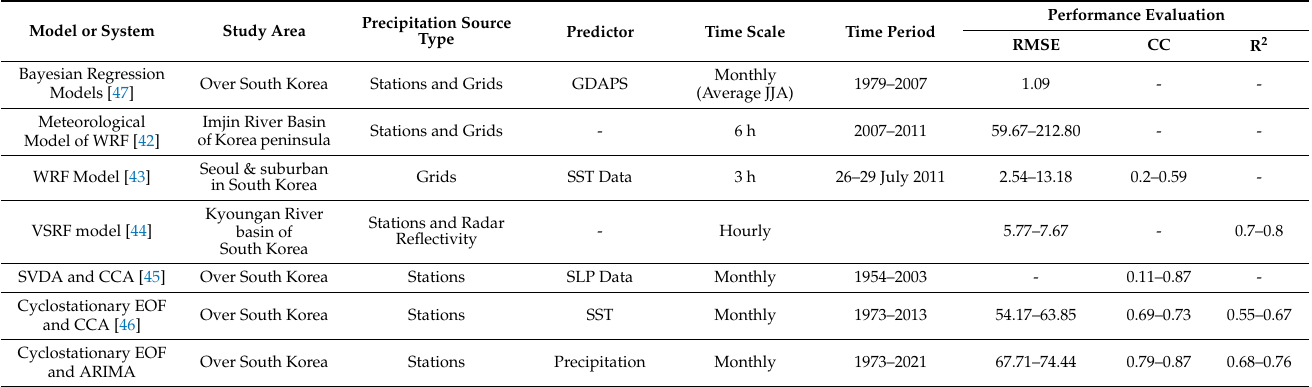
Table 2. Comparison of several precipitation forecasting models in